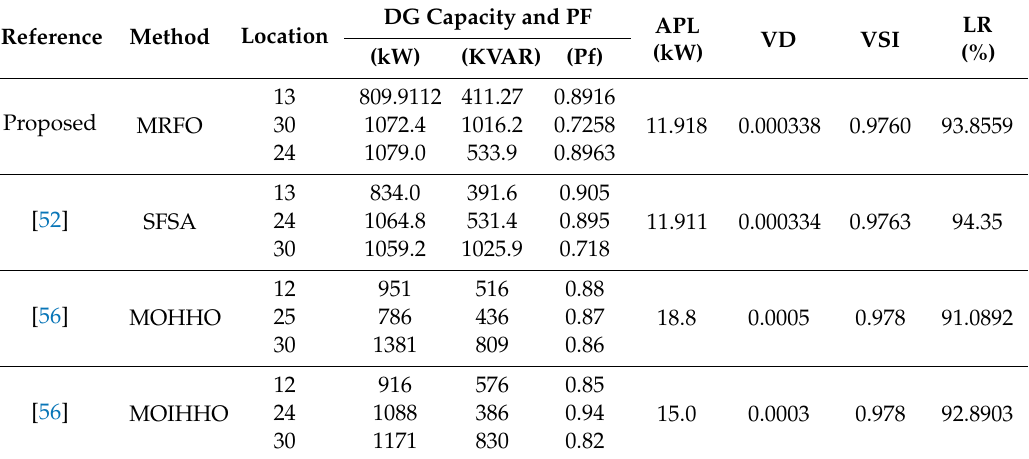
Table 4. 33-bus, three DG units at optimum